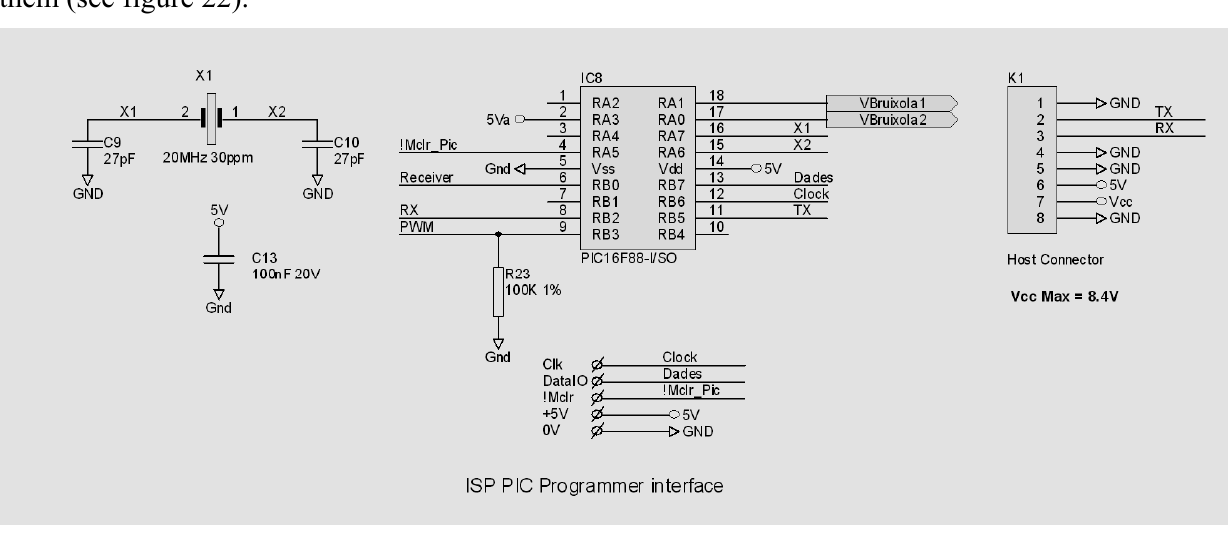
Figure 22 . Receiver control bloc.